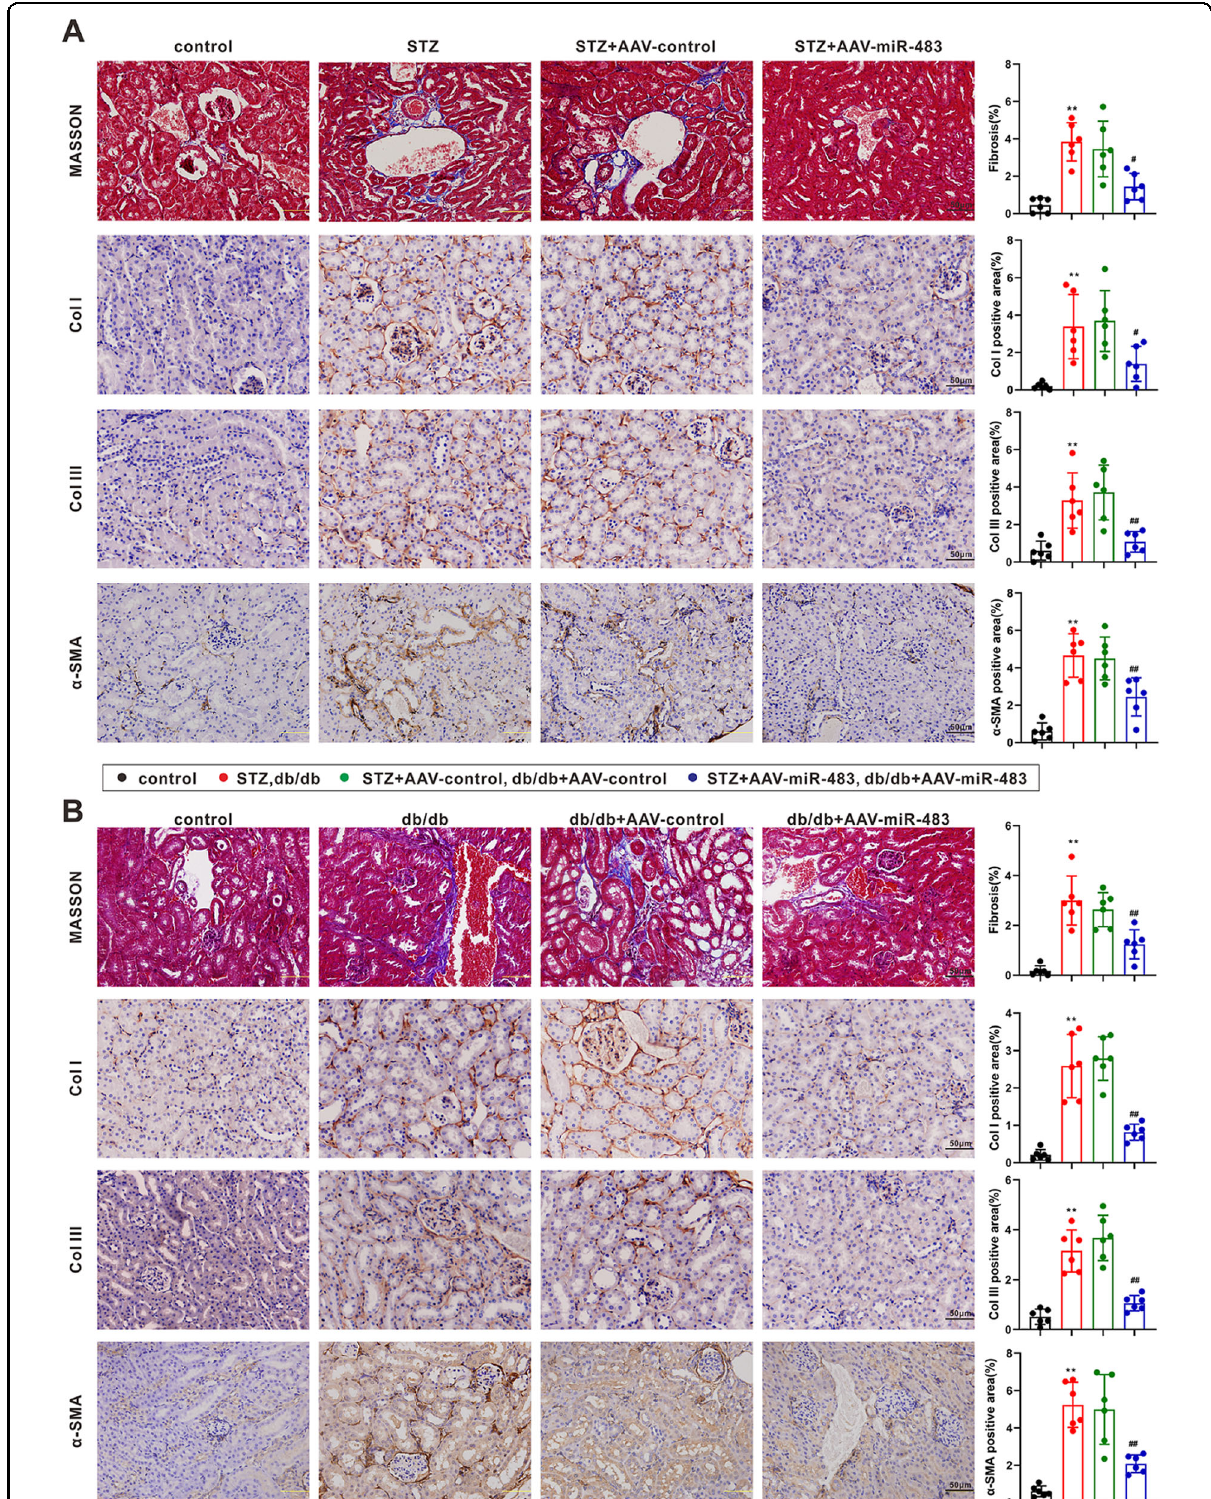
Fig. 4 Effect of miR-483-5p on the renal interstitial fi brosis in type 1 and type 2 diabetic mice. A , B The interstitial fi brosis in diabetic mice was observed by Masson staining and immunohistochemistry (Scale Bar = 50 μ m). ** P < 0.01 vs. control. # P < 0.05 vs. STZ + AAV-control or db/db + AAV- control. One-way ANOVA followed by Tukey ’ s or LSD post-test. st. STZ Streptozotocin, db/m db/misty, ACR albumin to creatinine